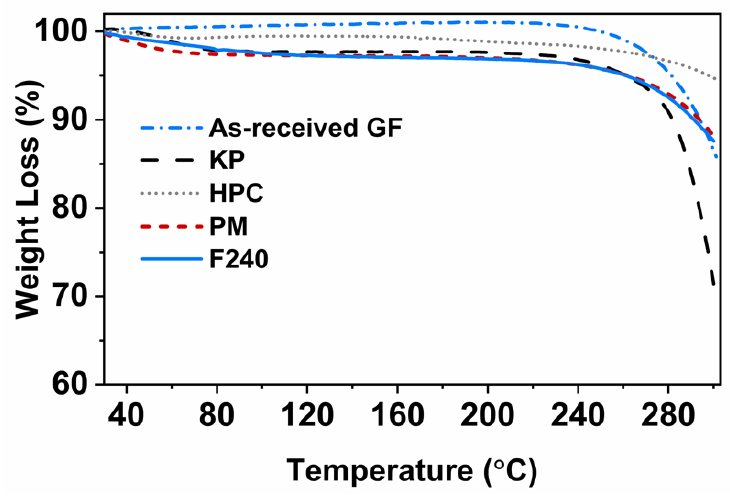
12 of 20 Figure 4. SEM images of as-received GF, KP powders, filament (H165), 3D printed tablet (F240) along with 3D printed placebo tablet (P240). 3.6. Thermal Stability The results for the thermo-gravimetric analysis (TGA) are presented in Figure 5. The weight loss for all the tested samples was less than 2.7% at 100 °C, which could be at- tributed to the free or bound water [23,80]. Similarly, Wei et al. [23] reported that 2–5% weight loss referred to the loosely bound moisture at temperatures up to 100 °C. At 240